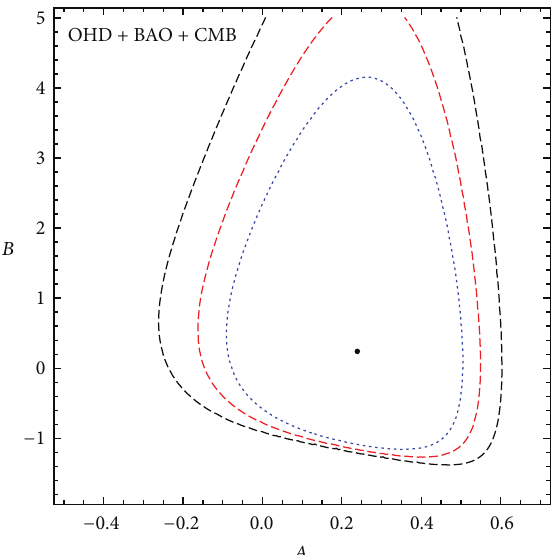
Figure 2: It shows the variations of 𝐴 with 𝐵 for 𝛼 = 0.1 for OHD and OHD + BAO analysis, respectively, for different confidence levels say 66% (solid, blue), 90% (dashed, red), and 99% (dashed, black) contours.